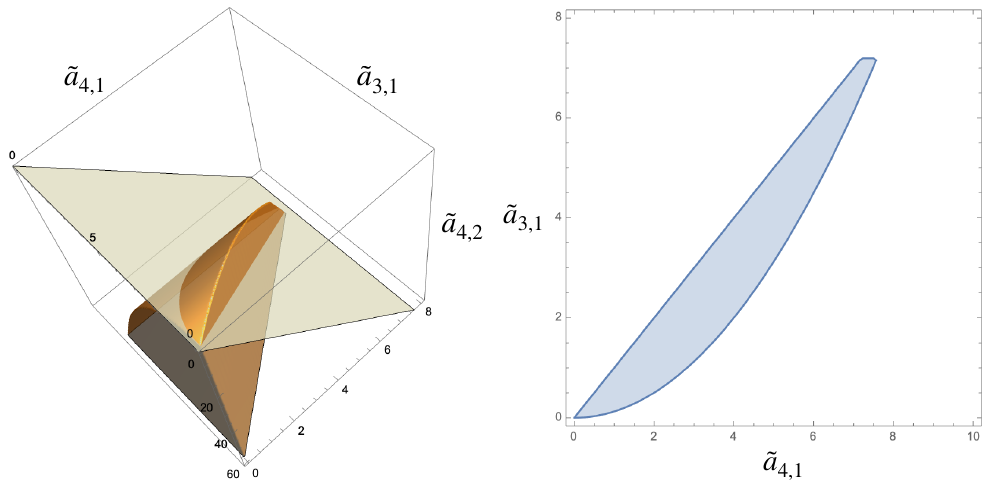
Figure 4 . (˜ a 3 , 1 , ˜ a 4 , 1 , ˜ a 4 , 2 ) space intersected with a 4 , 2 = 8 a 4 , 1 symmetry plane, and the resulting (˜ a ˜ a ) 3 , 1 , 4 , 1